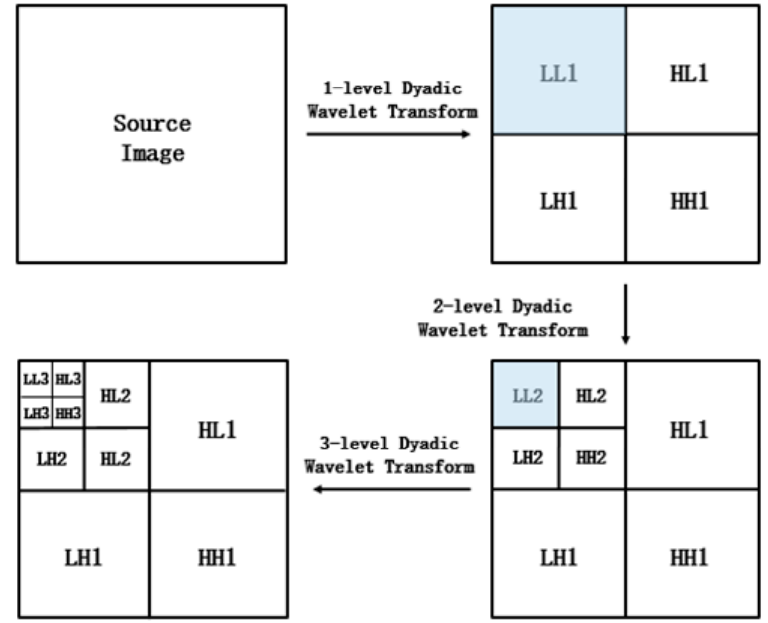
Figure 8. Sub-bands separated by a three-level dyadic discrete wavelet transform (DWT).